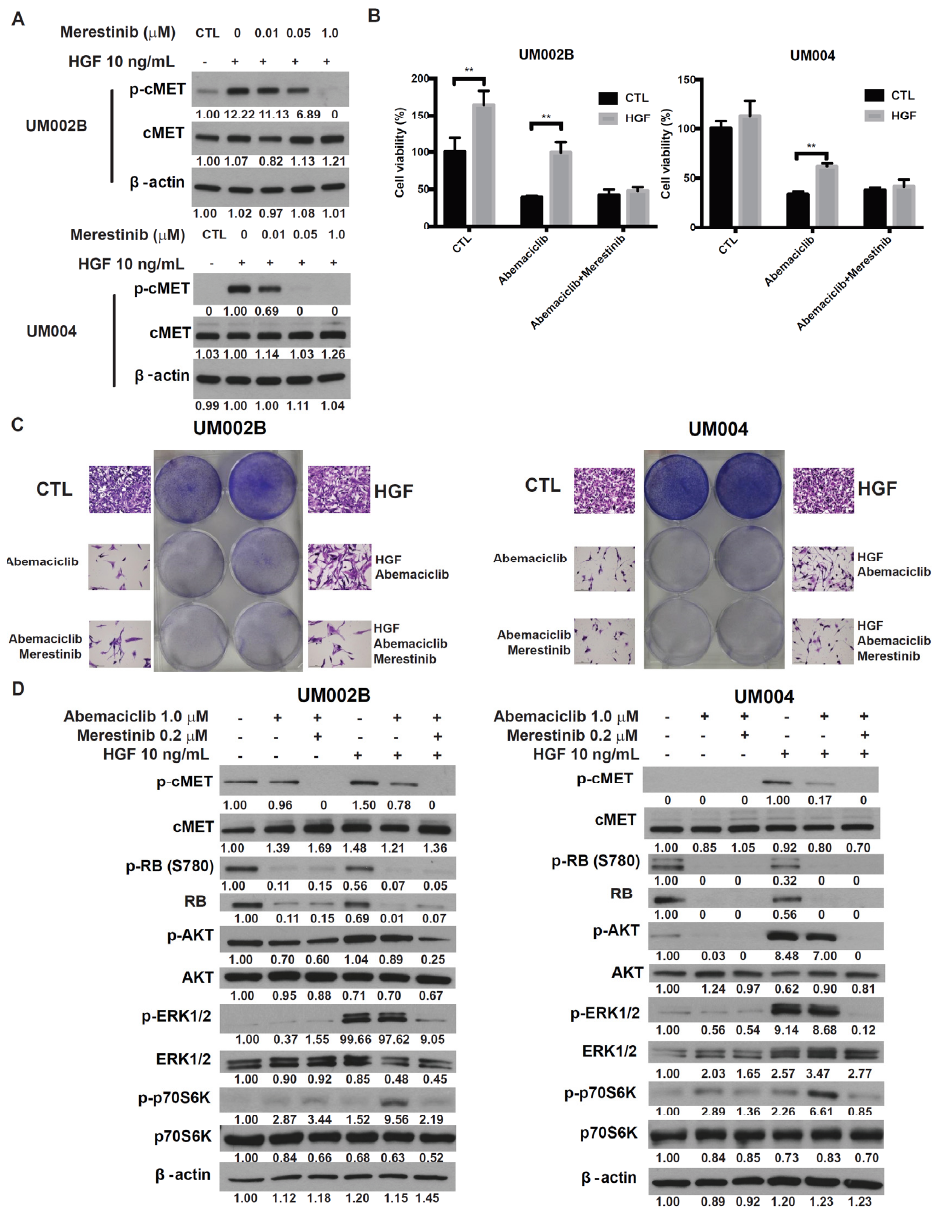
Figure 4. Merestinib overcomes HGF-mediated resistance to abemaciclib in metastatic uveal melanoma cells. ( A ) UM002B and UM004 cells were treated with merestinib for 4 h, followed by 10 ng/mL of HGF stimulation for 15 min. Phosphorylation of cMET was evaluated by Western immunoblotting of cell lysates with phospho-cMET antibody. Actin was used as the loading control. ( B ) UM002B and UM004 cells were treated with DMSO or 1 μ M abemaciclib, in combination with 10 ng/mL of HGF and/or 0.2 μ M merestinib for 4 days. Cell viability was determined by the MTS assay. Data are presented as mean ± SD. ** p < 0.01, based on the two sample t -test with unequal variance. ( C ) UM002B and UM004 cells were treated with DMSO or 1 μ M abemaciclib, in combination with 10 ng/mL of HGF and/or 0.2 μ M of merestinib for seven days. Cells were stained and representative images are shown. ( D ) UM002B and UM004 cells were pretreated with DMSO, 1 μ M of abemaciclib, or 0.2 μ M of merestinib for 48 h. Cells were then stimulated with 10 ng/mL HGF for 1 h, as indicated. Activation of cMET, RB, AKT, ERK1/2, and p70S6K was analyzed by Western immunoblotting.